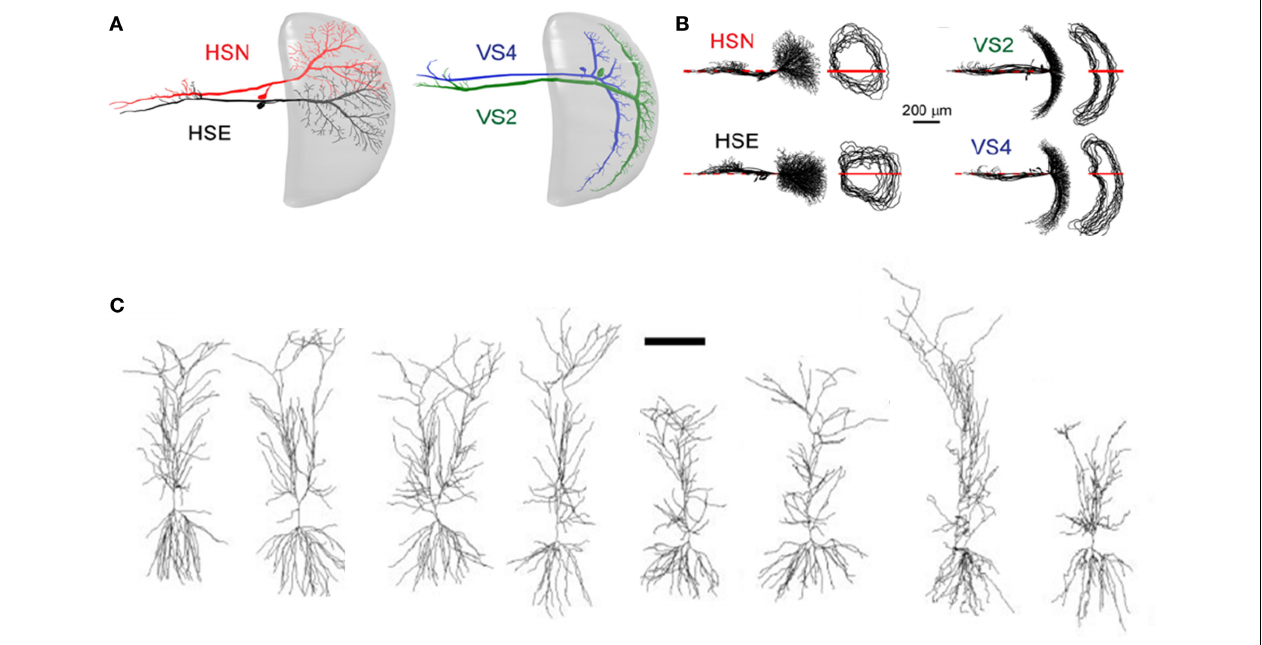
neuropile area that is covered by the neurites, and not by the complete branching topology. (C) Qualitative anatomical stereotypy in vertebrate neurons. Reconstructions of eight rat hippocampal CA1 pyramidal cells. Note that the gross fi eld covered by the neurites exhibits a similar trend in all eight neurons. Stereotypy seems to be less robust as compared to invertebrate identifi ed neurons. Scale bar: 200 µm. Panels (A,B) are adapted from Cuntz et al. (2008), with permission. Panel (C) is adapted from Scorcioni et al. (2004), with